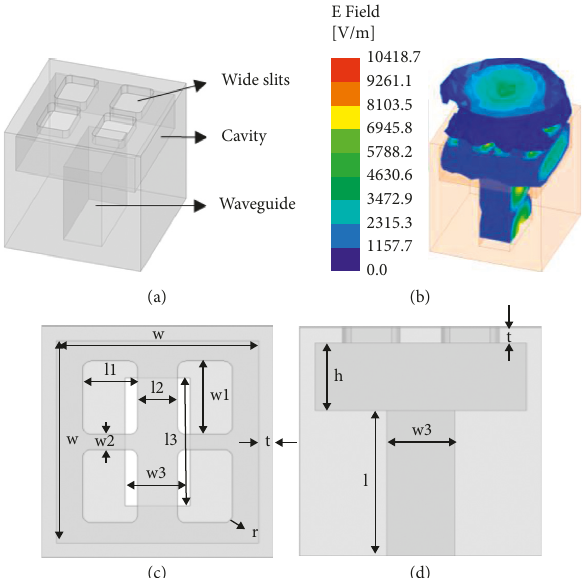
Figure 1: (a) Schematic, (b) electric field distribution, (c) top view, and (d) front view of the antenna unit. w l